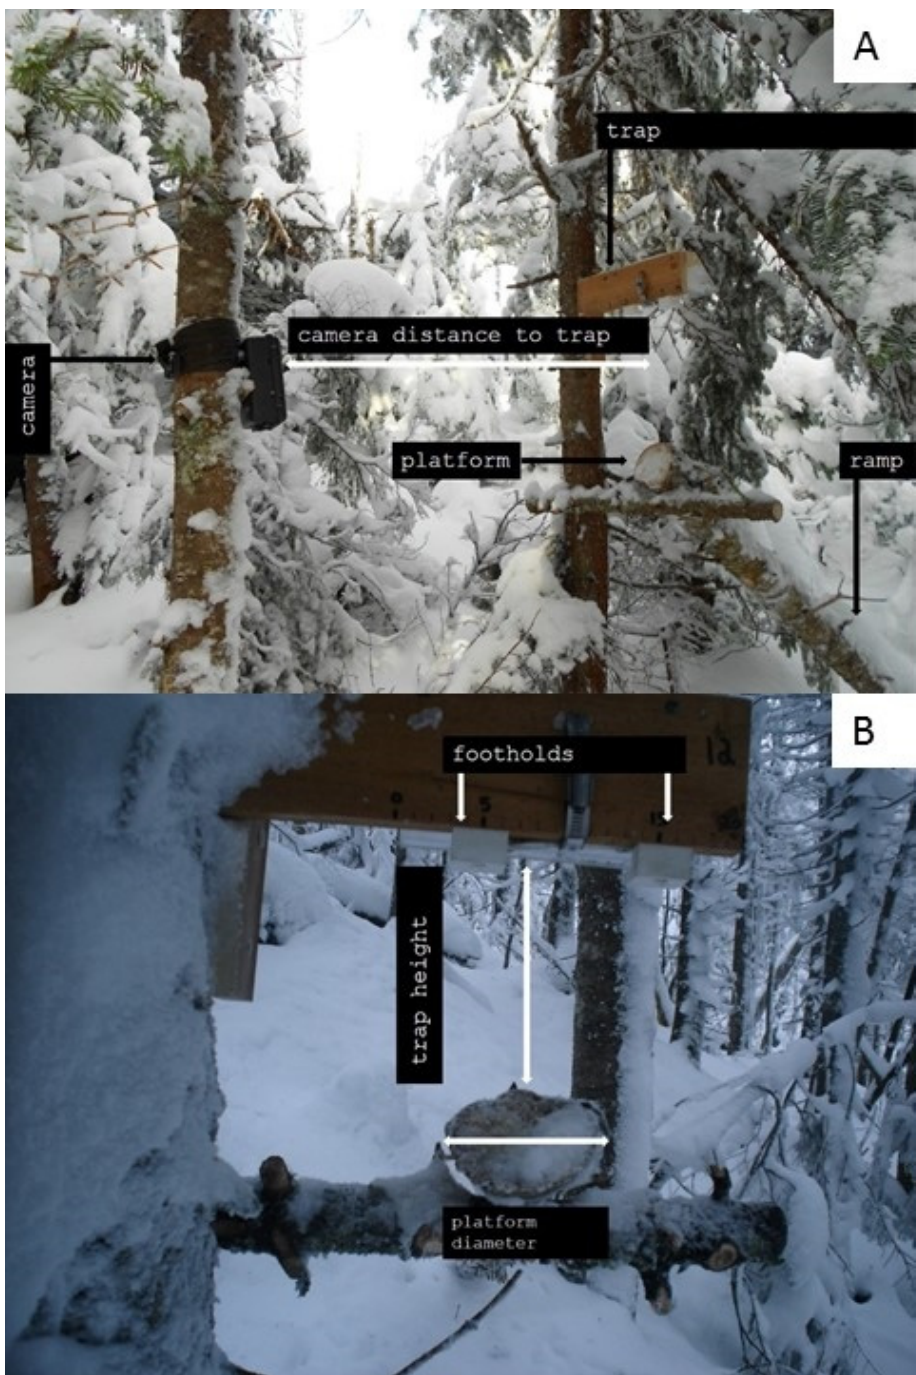
Figure 2. Overview of camera ‐ trap design ( A ) and components that were measured ( A , B ; white arrows) to determine the best configuration to capture marten ventral patterns.